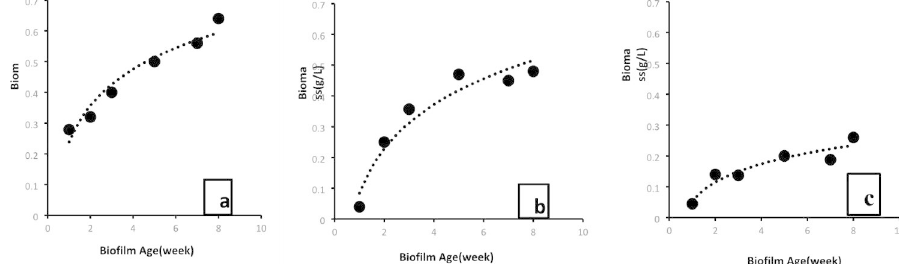
Fig. 5 Growth kinetics curves for cyanobacterial biofilms grown on three different materials: jute ( a ), cotton ( b ) and positive charge yarn ( c )